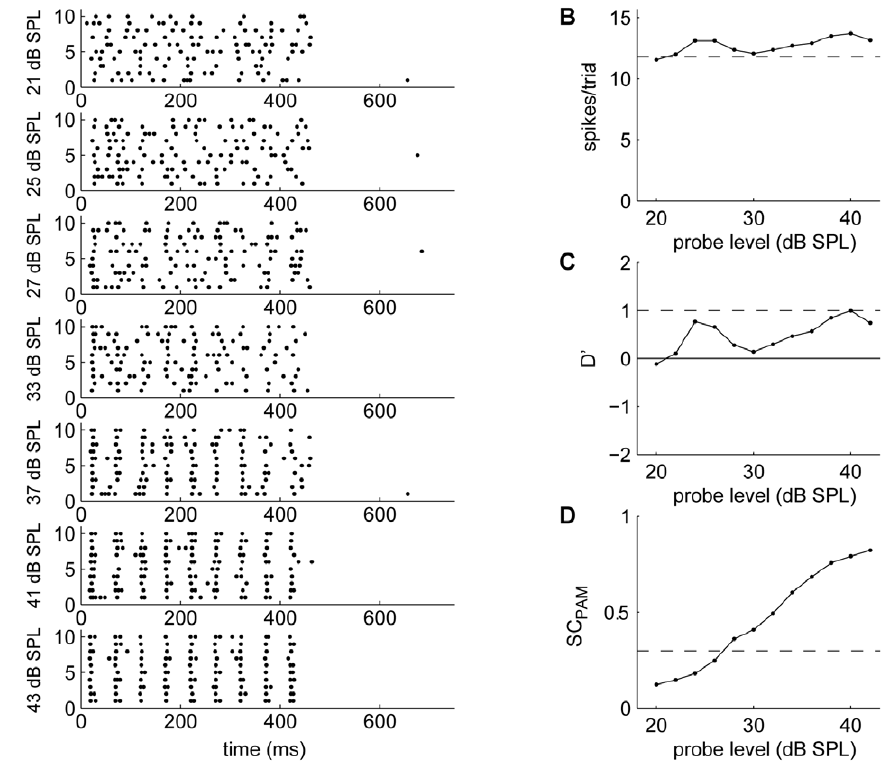
Figure 2. Example of a neuron that shows overt time locking to the probe. The unit’s responses to P + M u at increasing probe level ( A ) show firing periodicity corresponding to the envelope of the probe. The number of spikes remained approximately constant for increasing probe levels ( B , dashed line indicates response to noise alone) and d 9 did not reach threshold, and thus the probe is not detectable based on the d 9 -method ( C ). However, the probe signal is clearly detectable based on the SC ( D ).